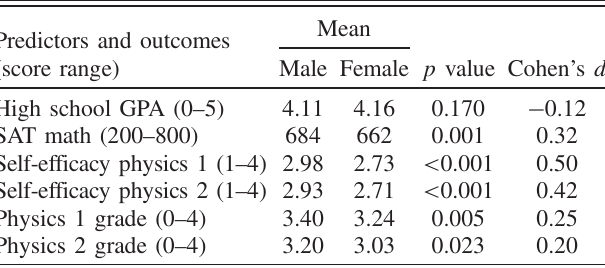
TABLE II. Mean predictor and outcome values by gender as well as statistical significance ( p values) and effect sizes (Cohen ’ s d ) by